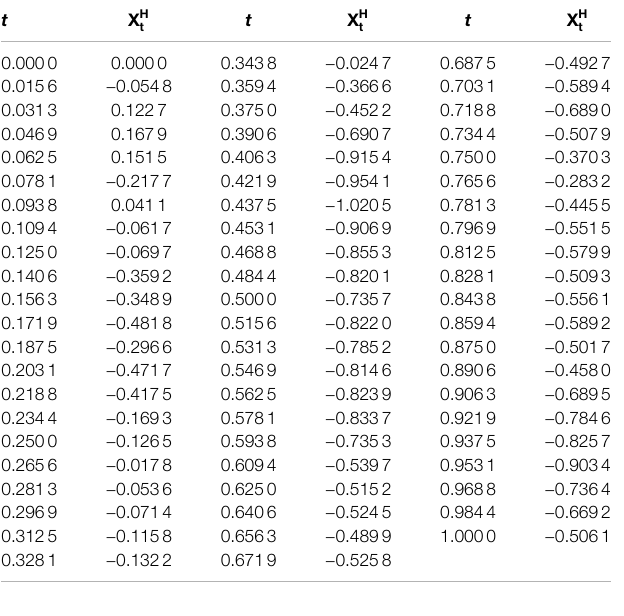
TABLE 5 | Data of X H t with θ (cid:1) 10 and H (cid:1) 0.5 TABLE 6 | Data of X H t with θ (cid:1) 100 and H (cid:1)